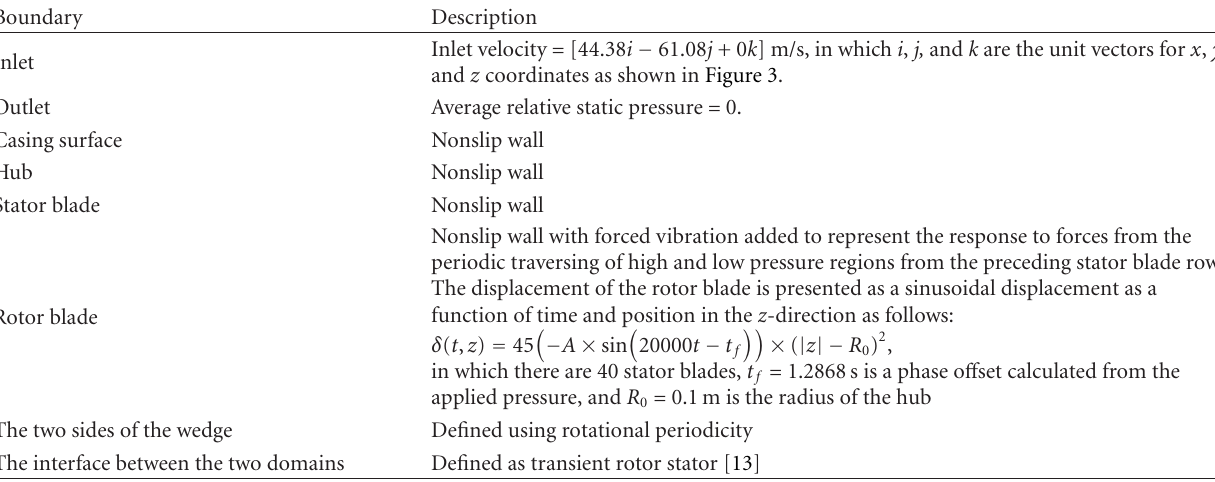
Table 1: Boundary conditions for the FSI model as shown in Figure